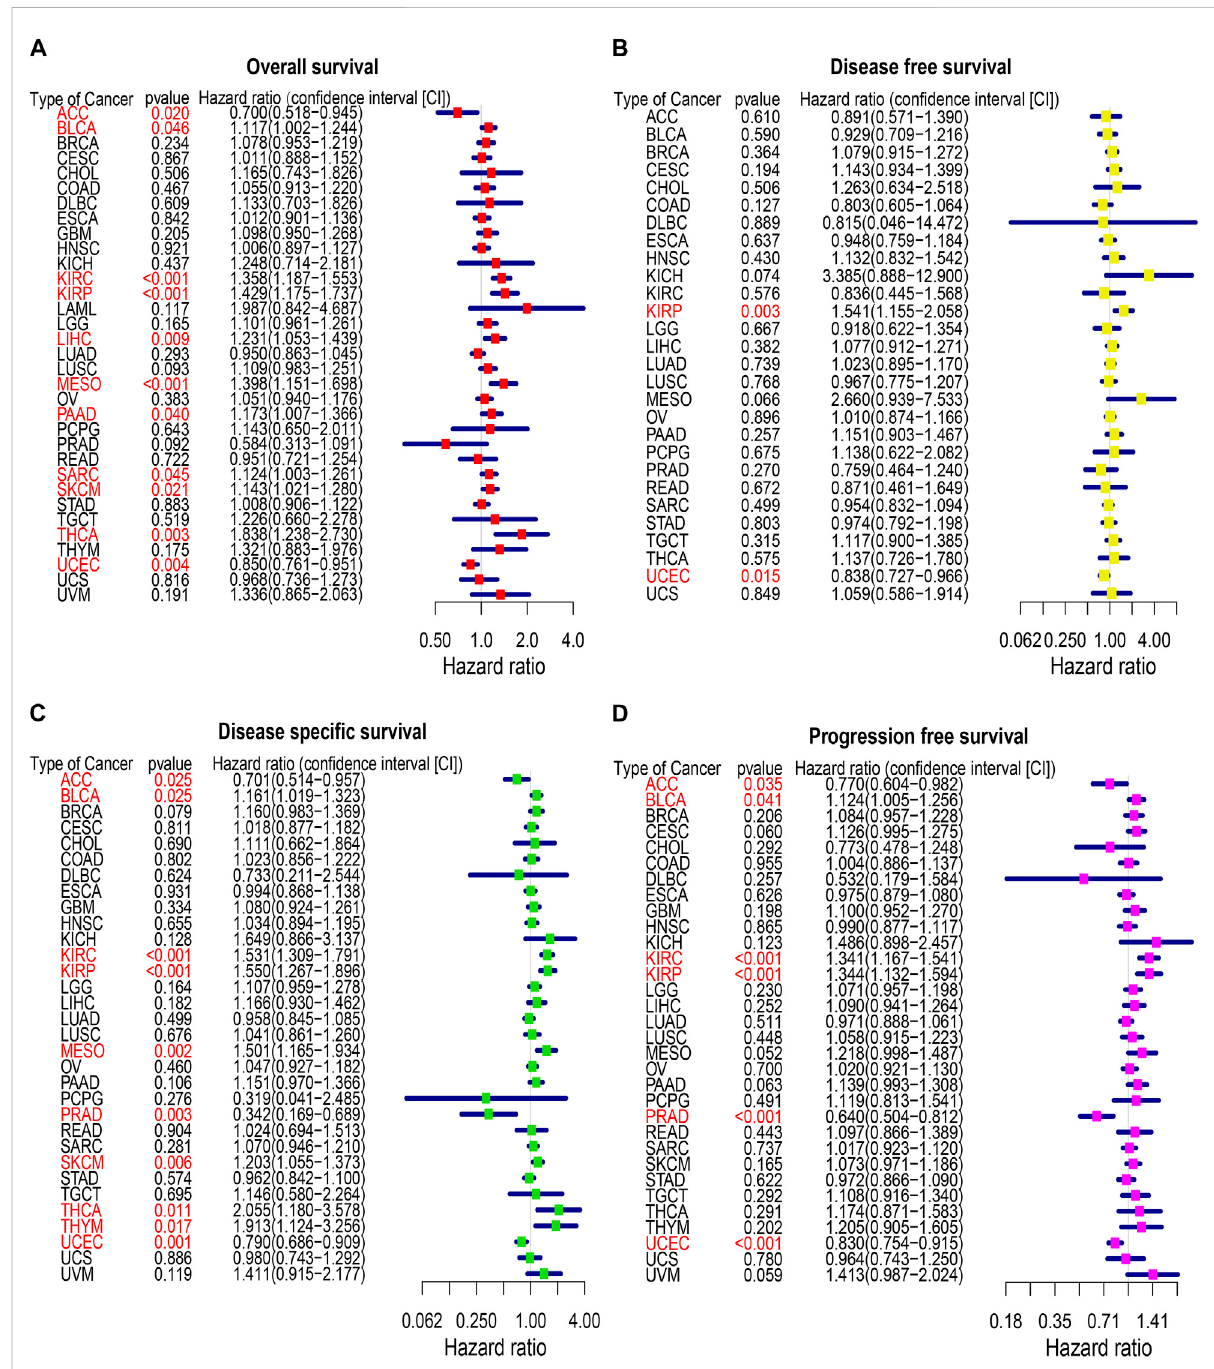
FIGURE 3 The forest map of univariate Cox regression analysis of CREB3L1. (A) Forest map shows the results of univariate cox regression analysis of CREB3L1forOSinTCGApan-cancer. (B) ForestmapshowstheresultsofunivariatecoxregressionanalysisofCREB3L1forDFSinTCGApan-cancer. (C) Forest map shows the results of univariate cox regression analysis of CREB3L1 for DSS in TCGA pan-cancer. (D) Forest map shows the results of univariate cox regression analysis of CREB3L1 for PFS in TCGA pan-cancer. Red items indicate the statistical signi fi